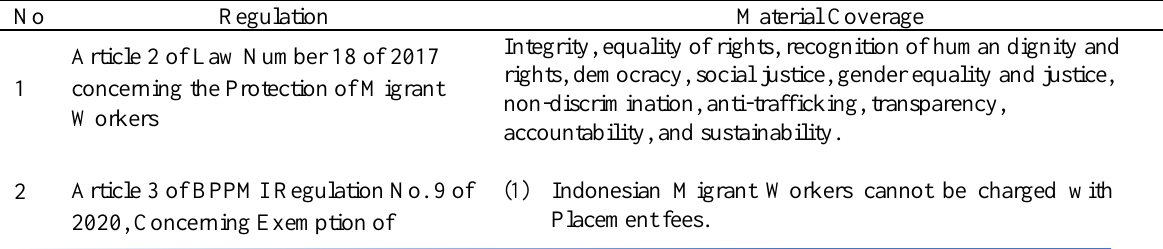
Table 1. The ASEAN Consensus on the Promotion and Protection of the Rights of Migrant Workers